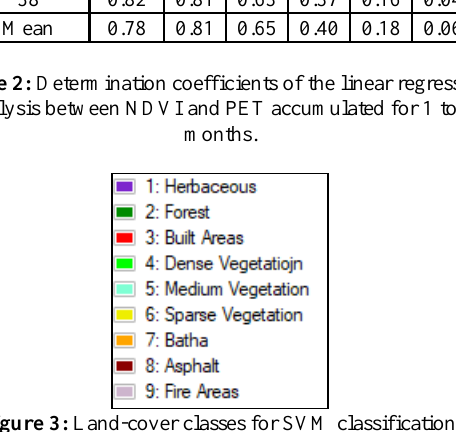
Table 1: Determination coefficients of the linear regression analysis between NDVI and rainfall accumulated for 1 to 6 months.